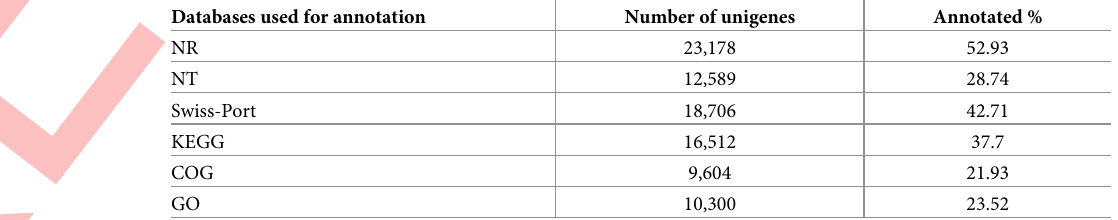
Table 3. Summary of unigene annotation of the Rhynchophorus ferrugineus fat body tissues transcriptome. Databases used for